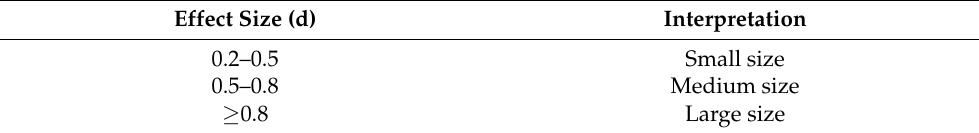
Table 3. Interpretation of effect size.